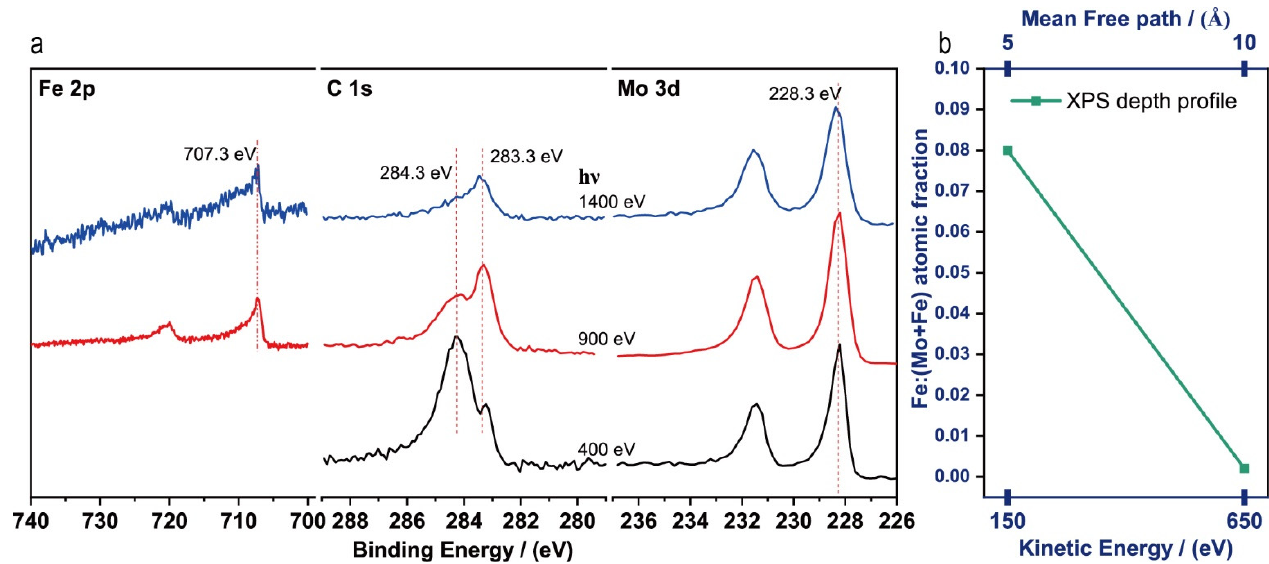
Figure 4. ( a ) Fe 2p, C 1s, and Mo 3d X-ray photoelectron spectroscopy (XPS) spectra of the prepared 1.5Fe-Mo 2 C-550 catalyst pretreated in a 20%CH 4 /H 2 atmosphere using a synchrotron-based XPS instrument with variable incident photon energies. ( b ) Dependence of Fe/(Fe + Mo) atomic fractions of as-synthesized 1.5Fe-Mo 2 C-550 catalyst measured using synchrotron-based XPS as a function of photoelectron kinetic energy and mean free path.